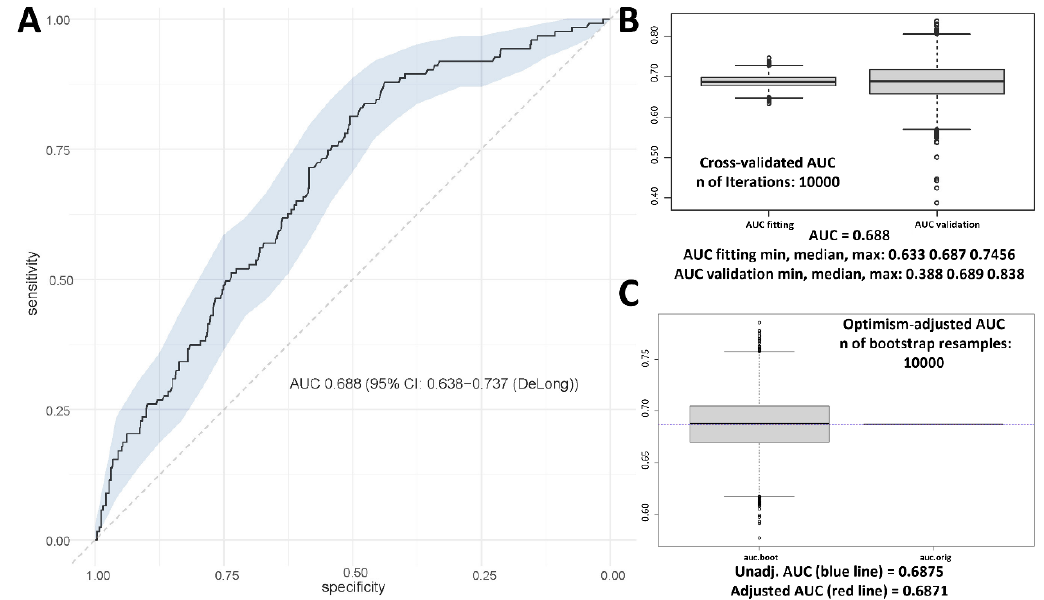
Figure 1. ( A ) Discrimination ability of the final model evaluated by calculating the AUC; ( B ) internal cross validation performed with the “modelvalid” function in R; ( C ) optimization-adjusted AUC calculated with the “aucadj” function in R.